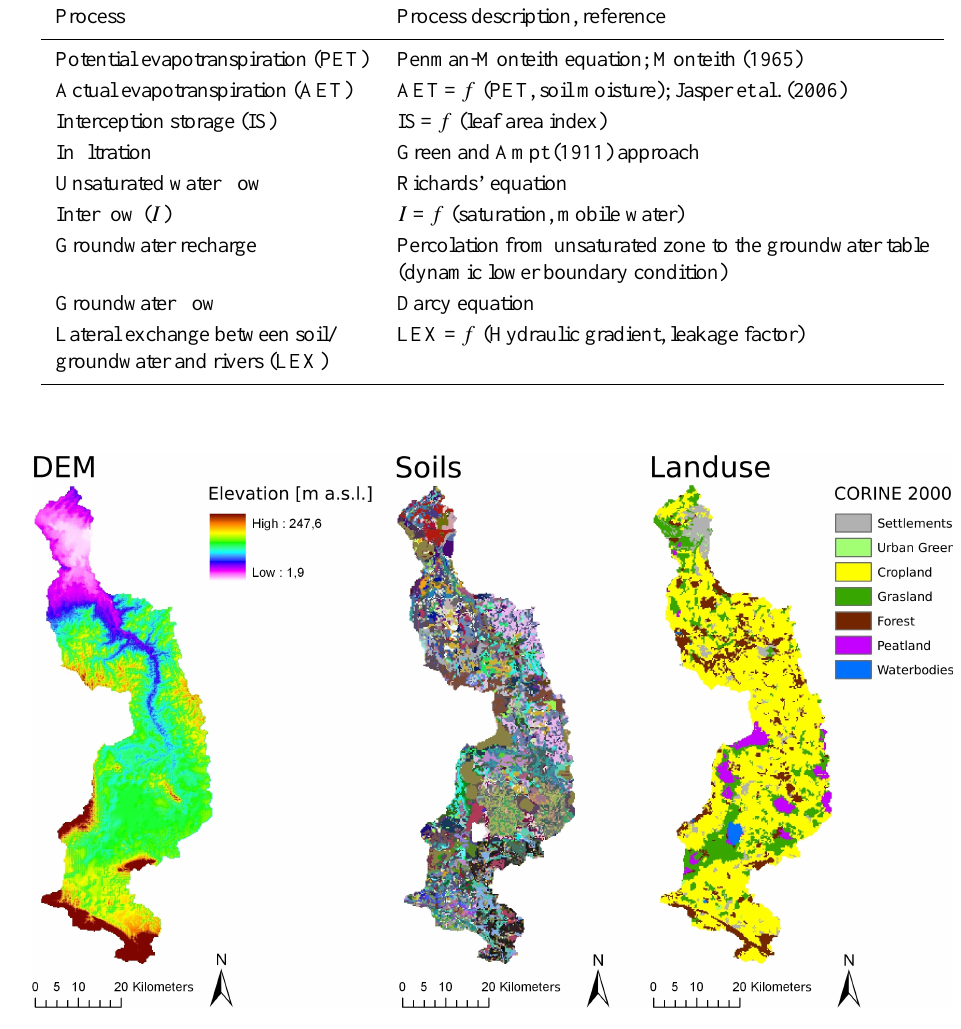
Fig. 2. Physiographic catchment characteristics: topography (digital elevation model, 50m resolution), soils (soil map 1:50000) and current land use (CORINE data set of the year 2000). The soil map does not include a legend due to the large number of different soil types (434 different soil profiles).